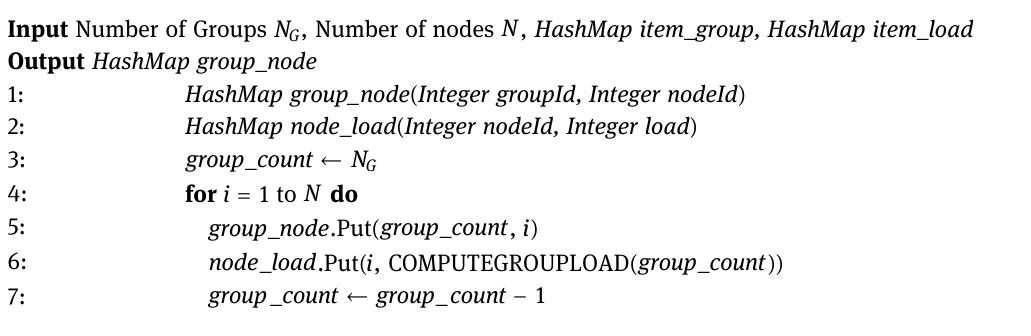
Algorithm 4 Balanced assignment of groups to nodes